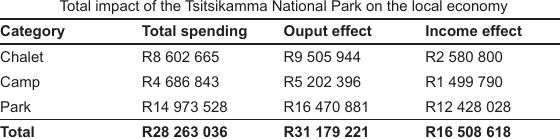
TABLE 4 Total impact of the Tsitsikamma National Park on the local economy